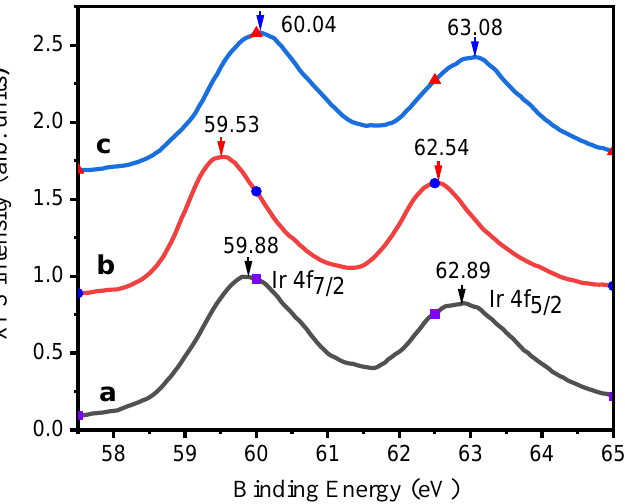
Figure 4. Ir 4f XPS spectra of ( a ) compound 1 , ( b ) (4cpbo) 2 Ir III ( µ -Cl), and ( c ) [(dfpbo) 2 Ir IV ( µ -O)] 2 .